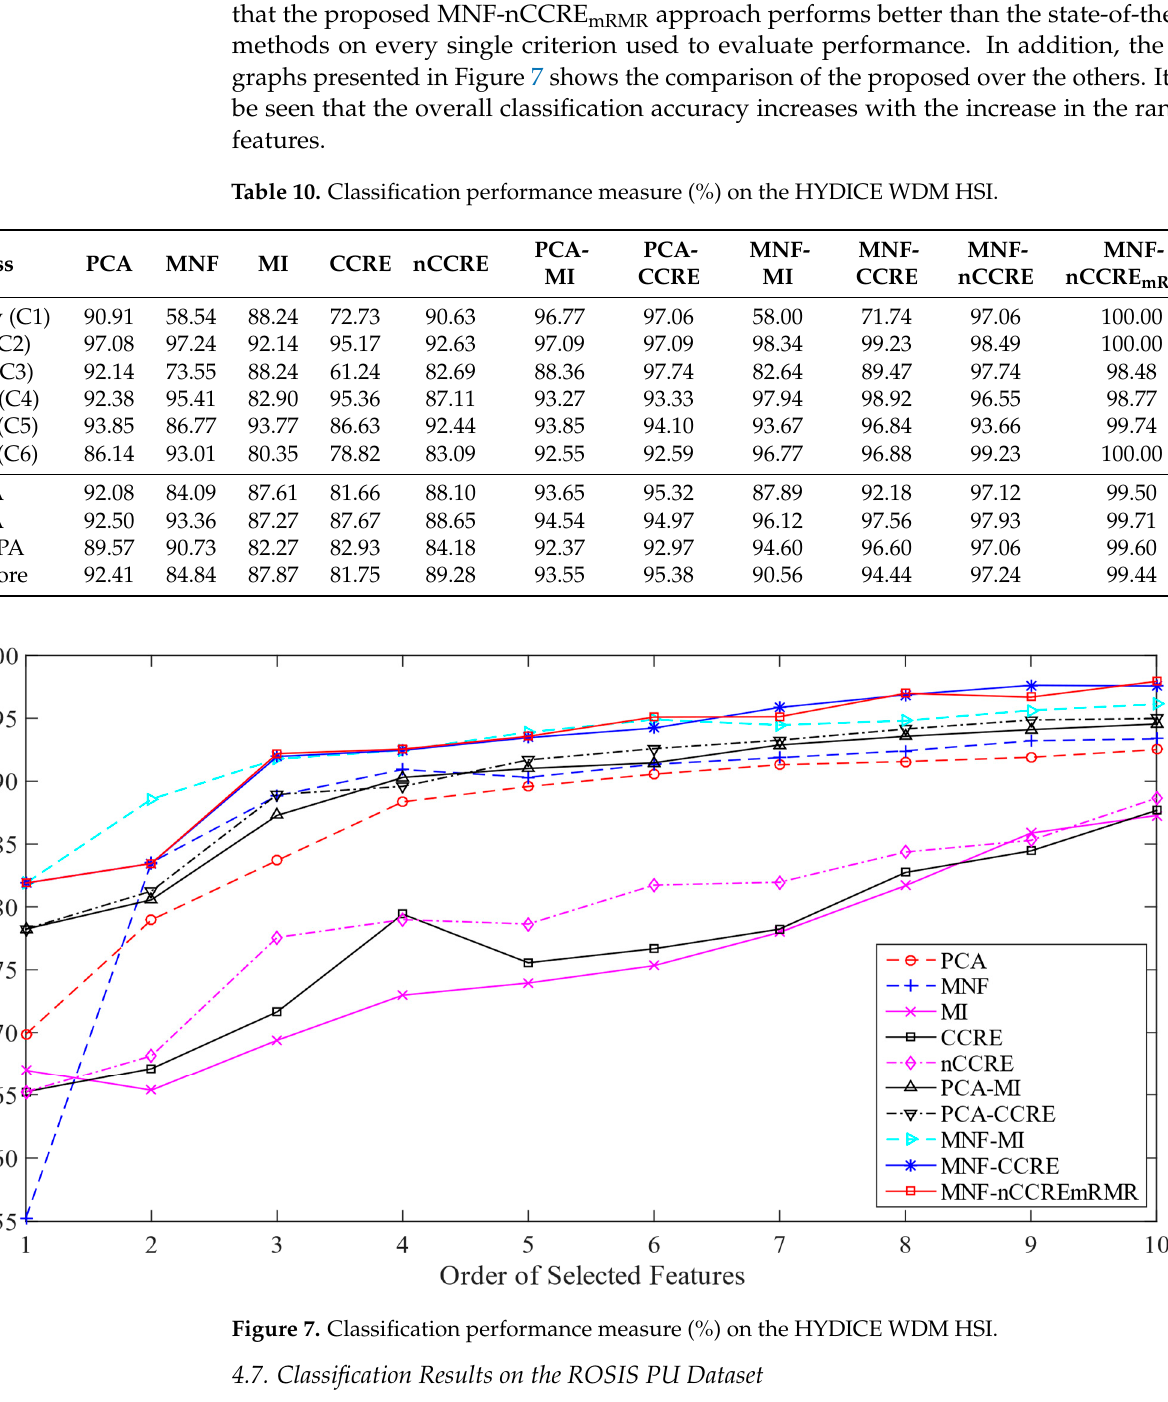
For the ROSIS PU dataset, we took approximately 17% samples of each class as training set and 83% samples as testing set from a total of 20,075 samples. The detailed